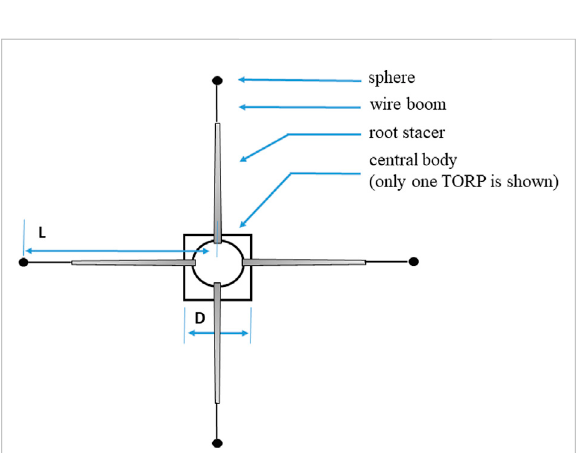
FIGURE 4 De fi nition of a single boom length, L, and spacecraft diameter, D. The components of each boom (root stacer, wire boom and sphere) are also de fi